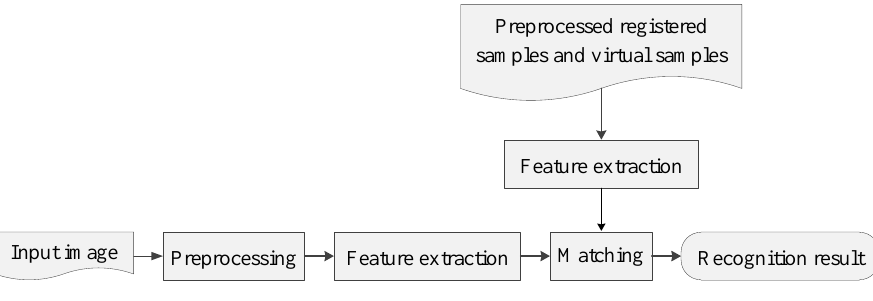
Figure 2. Overview of the recognition